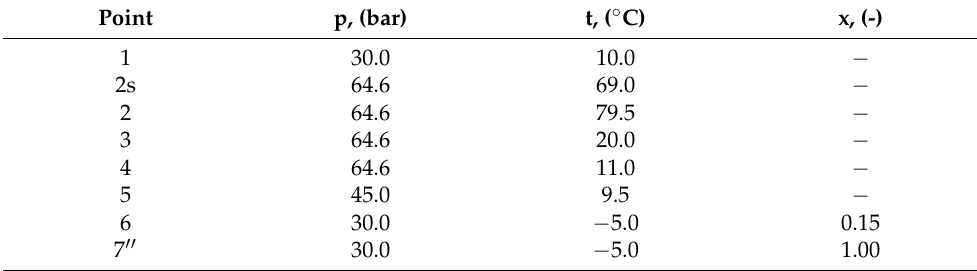
Table 2. Parameters of the subcritical cycle (characteristics points).